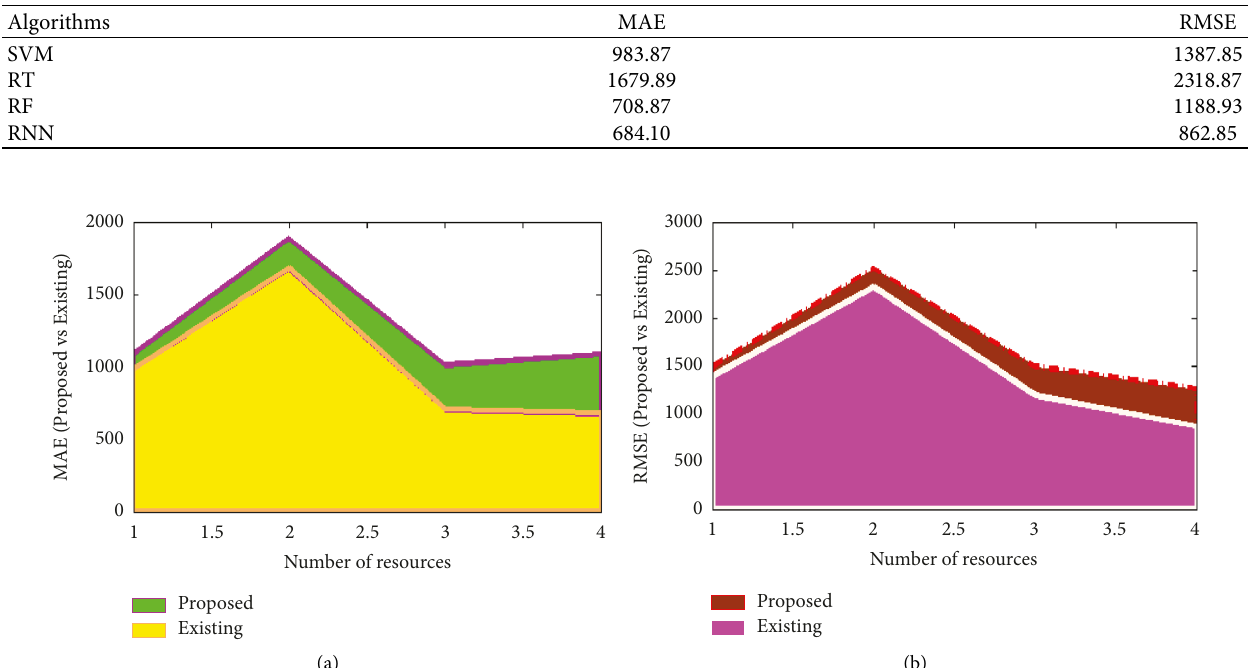
Table 5: Comparison of MAE and RMSE for the selected